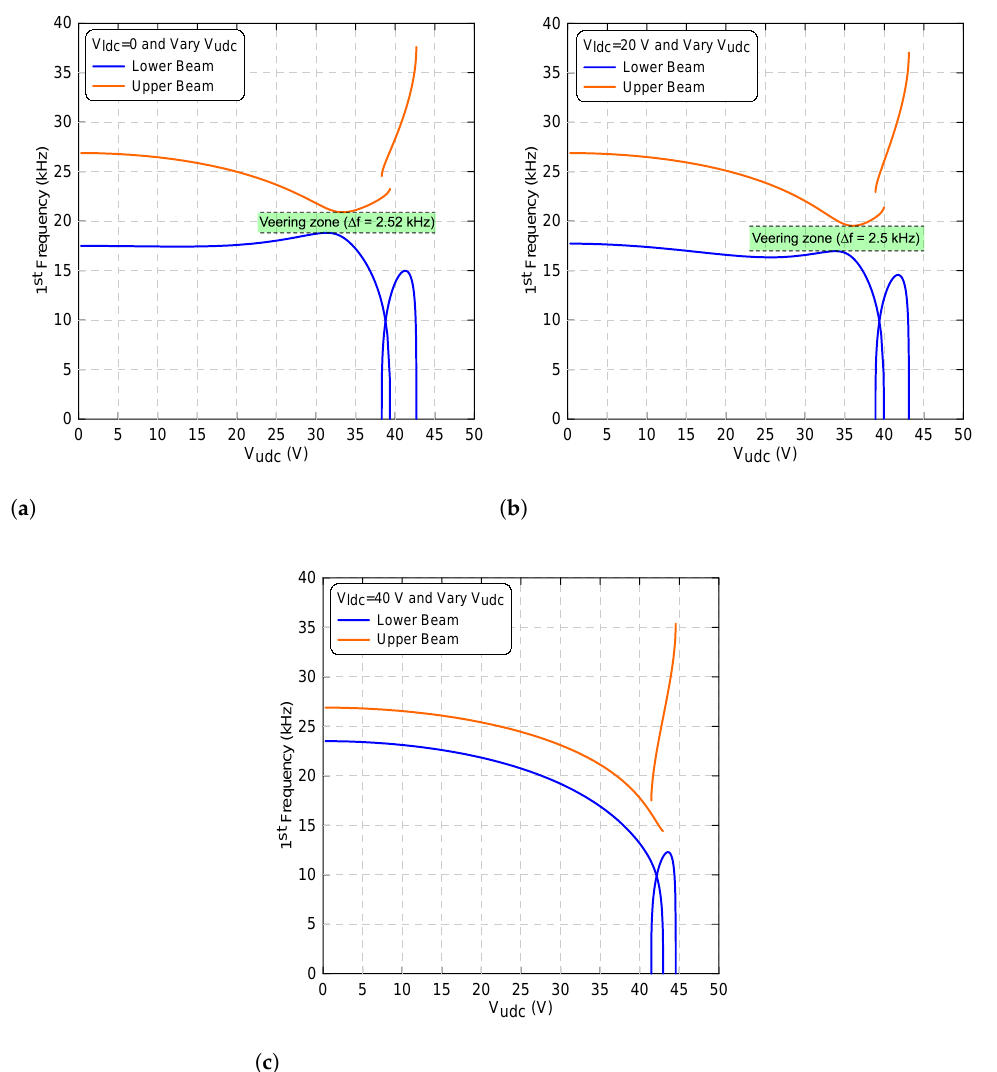
Figure 9. The variation in the first resonance frequency of the lower beam f l 1 and of the upper beam f u 1 as a function of the upper static voltage using three-symmetric modes ROM and a lower voltage sets to: ( a ) V ldc = 0, ( b ) V ldc = 20 V and ( c ) V ldc = 40 V. The lower beam results are marked with blue lines and the upper beam results are marked with orange